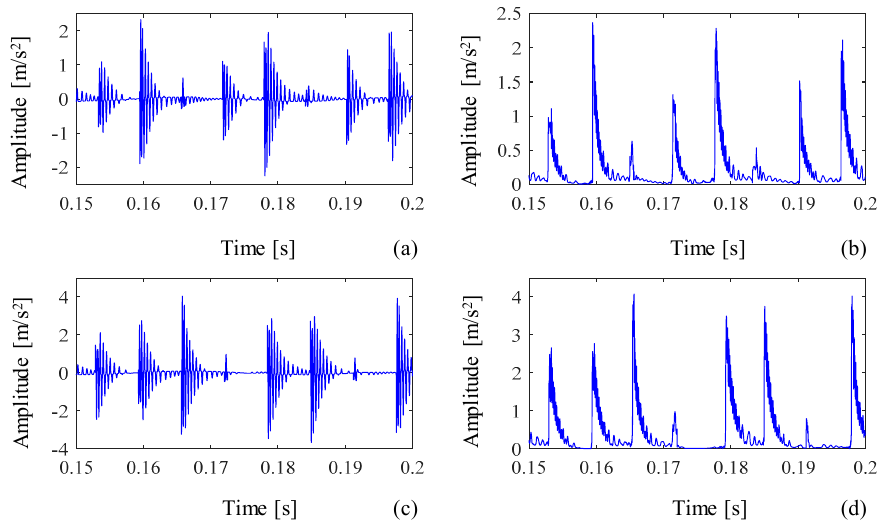
Figure 8. The generated data with inner race fault: ( a , b ) are the original data and the envelop data when the rotation speed is 1797 rpm; ( c , d ) are the original data and the envelop data when the rotation speed is 1730 rpm.